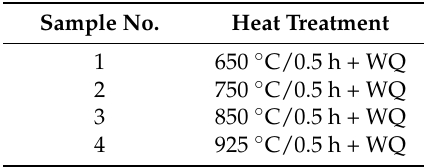
Table 1. Details of heat treatment for LAM Ti–26Nb alloys.